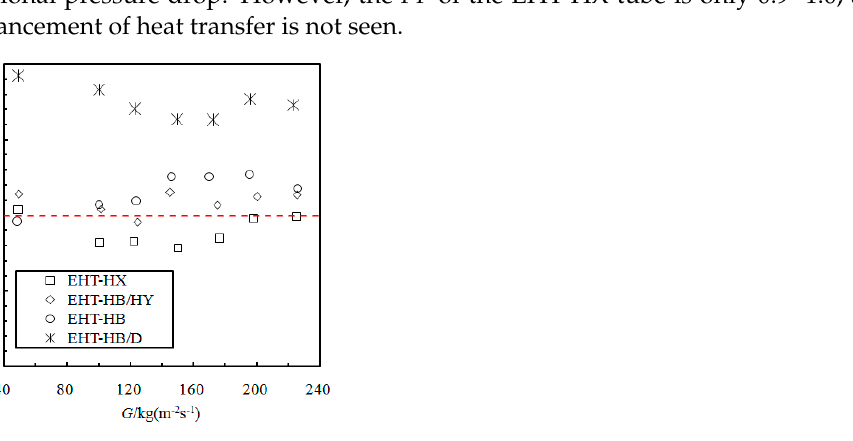
Figure 5. Comparison of performance factors of the evaluated enhanced tubes.